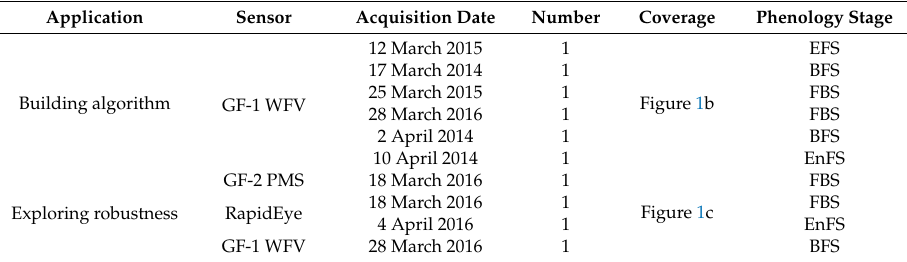
Table 1. The information of GF-1 WFV, GF-2 PMS, and RapidEye images used to build and verify the CSRA method. EFS, FBS, BFS, and EnFS in the table are the abbreviations of early flowering stage, full blooming stage, blossoming stage, and end flowering stage,